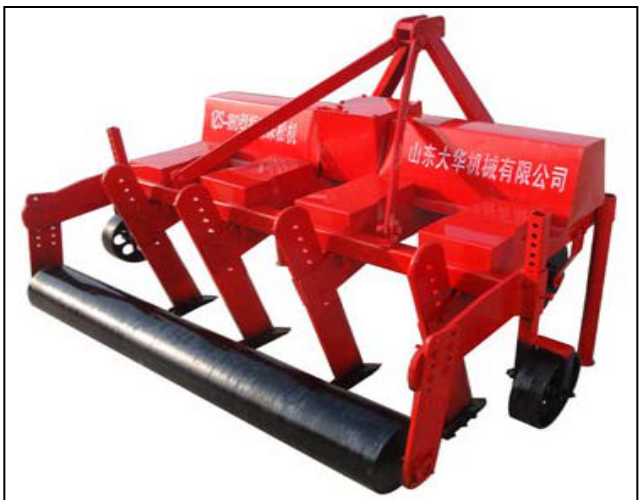
Figure 2. DaHua BaoLai 1SZ-180 forced-excited vibration subsoiler (http://www.nongjitong.com/ product/dahua_1sz-270_deep_loosening_machine.html (accessed on 12 November 2020)).